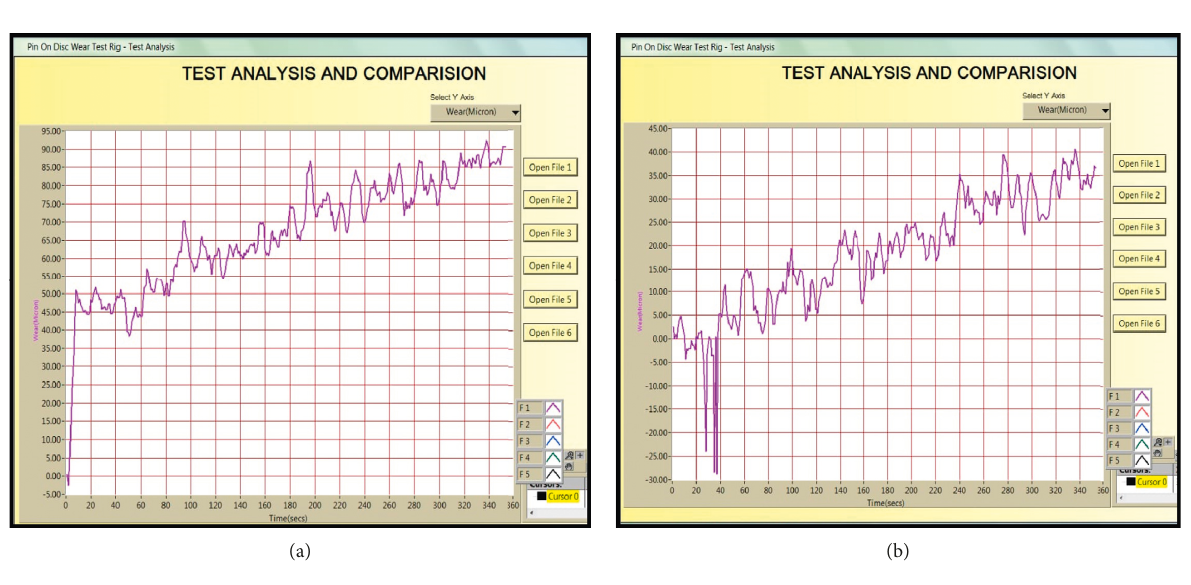
Figure 12: Wear test